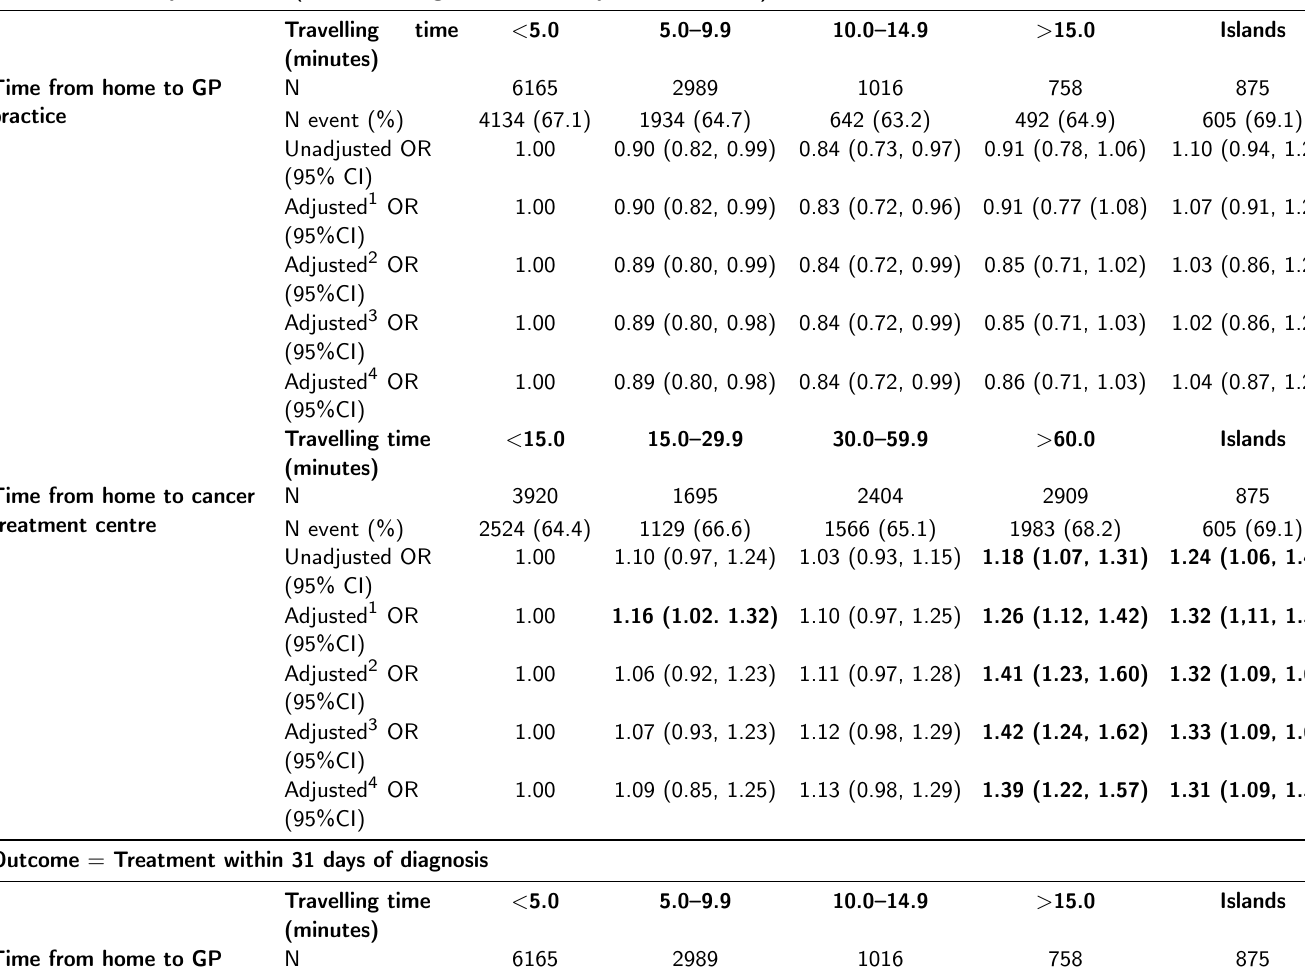
Table 6: Patient outcomes and relationships of travelling time from home to GP and cancer treatment centre Outcome = Timely treatment (treatment began within 62 days of GP referral)